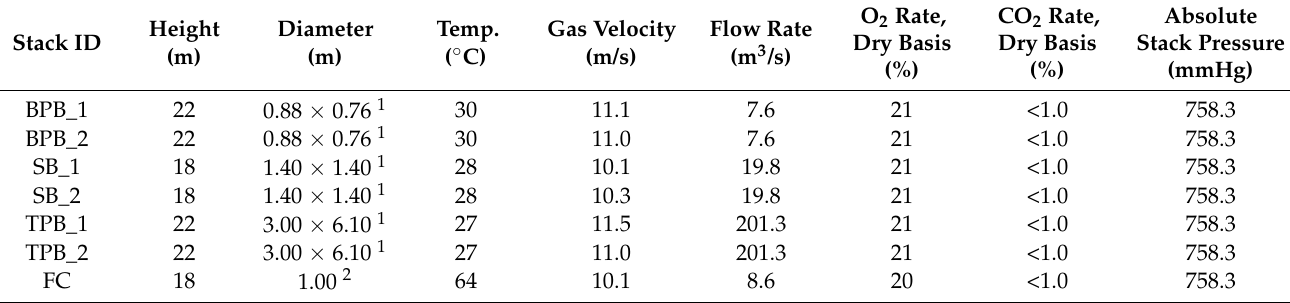
Table 1. Physical characteristics of sampling